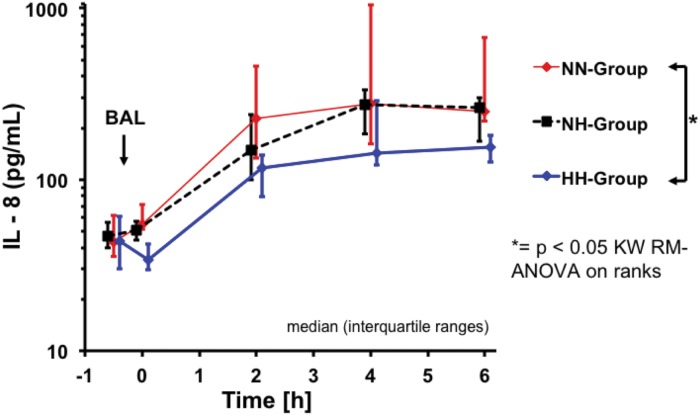
Plasma interleukin-8 over time.* = p< 0.05, NN- vs. HH-groups.